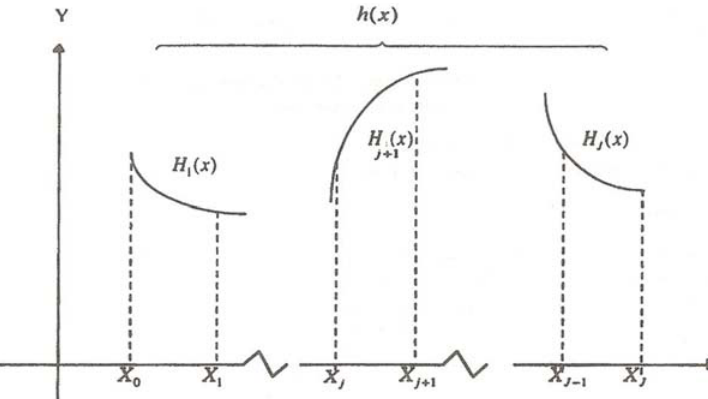
Figure 2. An illustration of the interpolating function